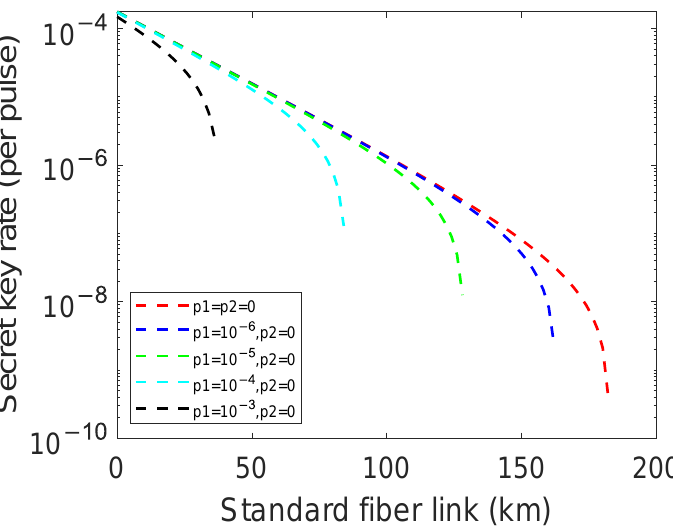
Figure 1. (Color online) The secret key rates (per pulse) in logarithmic scale versus transmission distance between Alice and Bob when just one party exists the weak randomness parameters and p 1 = 0,10 − x ( x = 6,5,4,3 ) (curves from right to left) and another one do not exist weak randomness p 2 = 0 for fixed N = 10 15